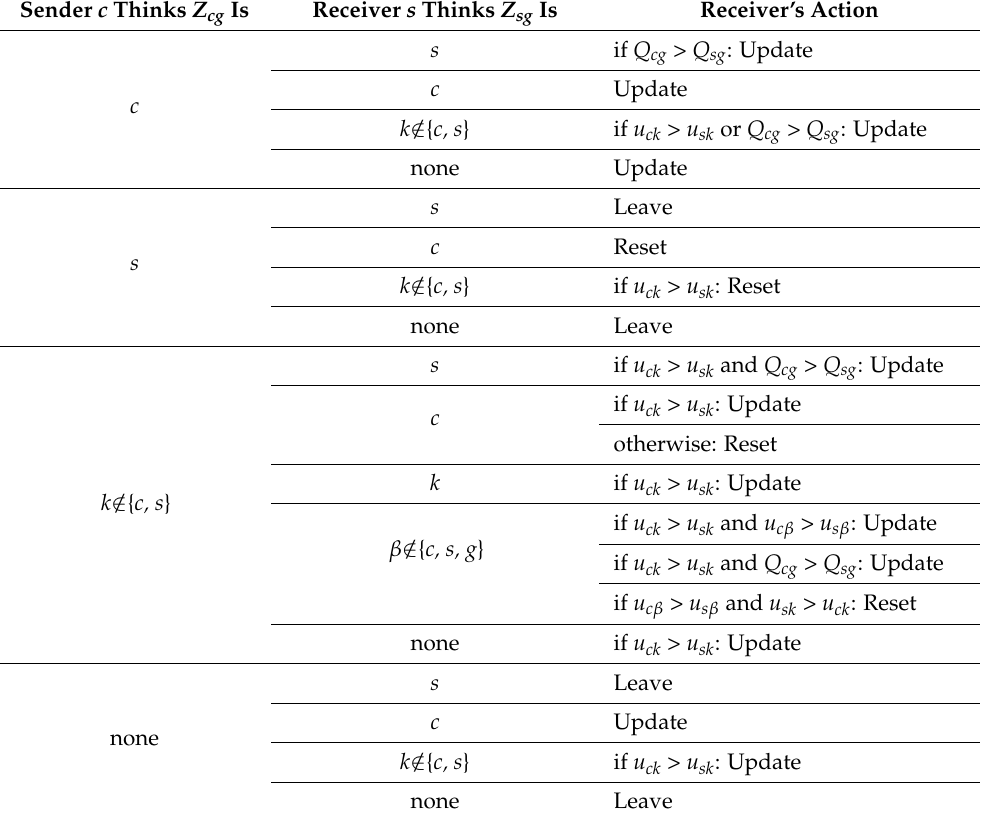
Table 2. Consensus